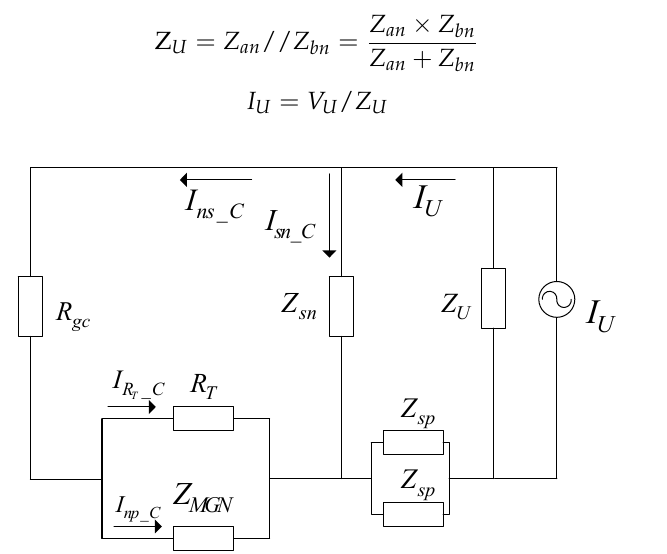
Figure 3. The equivalent analysis circuit for the unbalanced current totally caused by the customer.